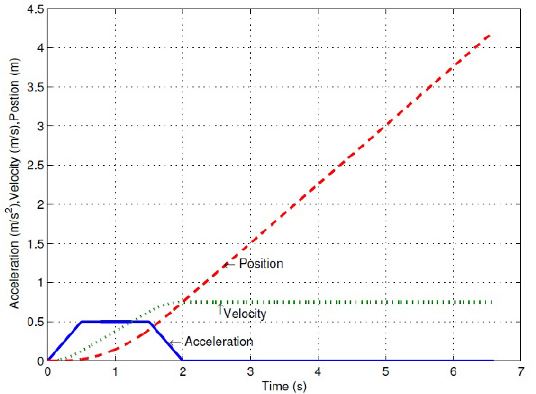
Figure 4. Frequency response from the control input to the air- gap/current outputs